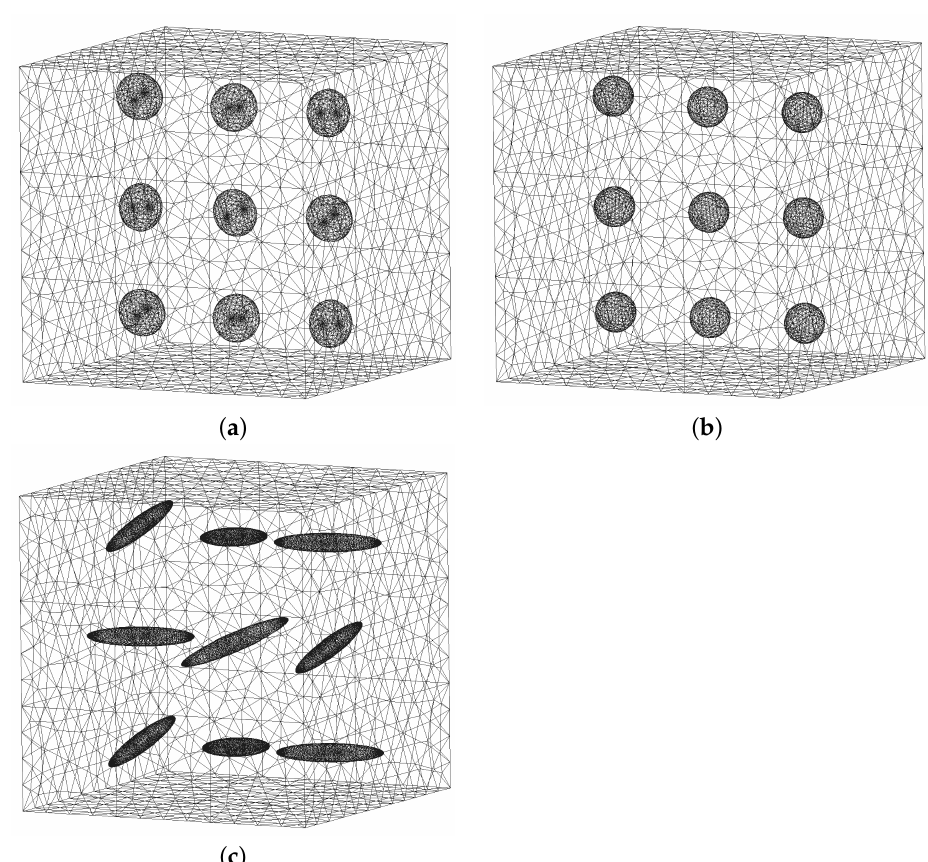
Figure 7. Discretization for one-eighth of the periodic cells using ANSYS (Solid187 element) for different inclusion shapes with a 1% inclusion volume fraction and a 10 ◦ fiber orientation: ( a ) discs ( α = 0.6), ( b ) spheres ( α = 1) and ( c ) ellipsoids ( α = 10).